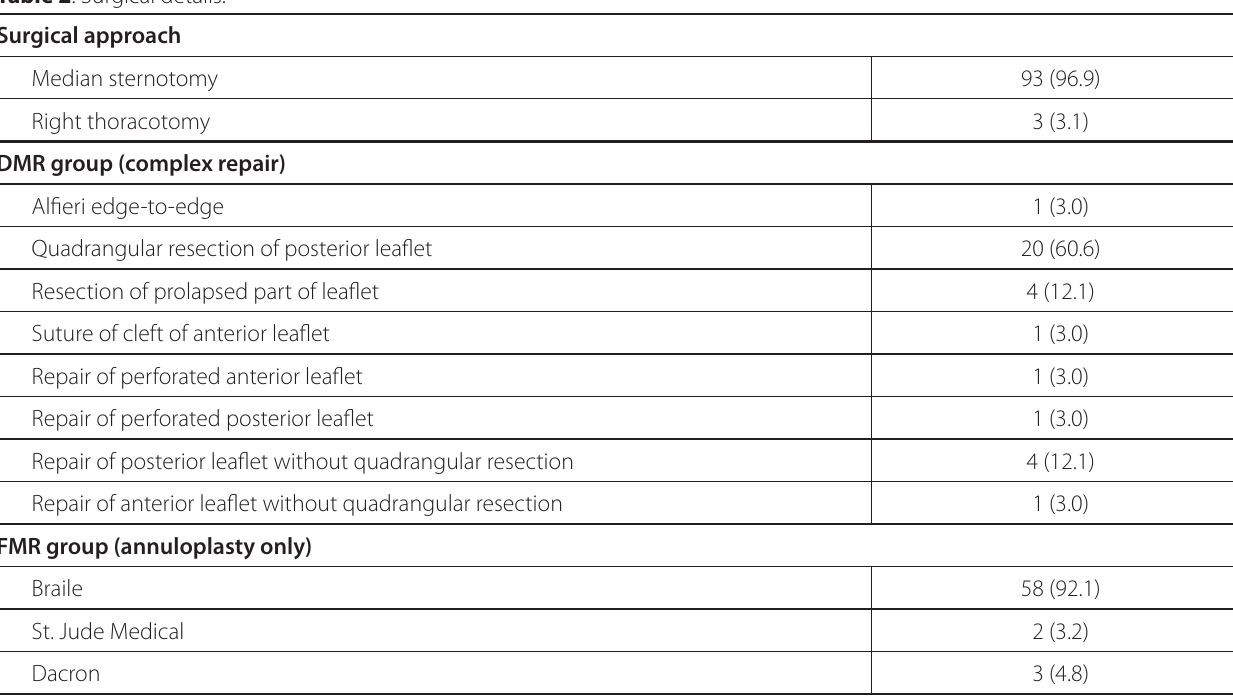
Table 2 . Surgical details. Surgical